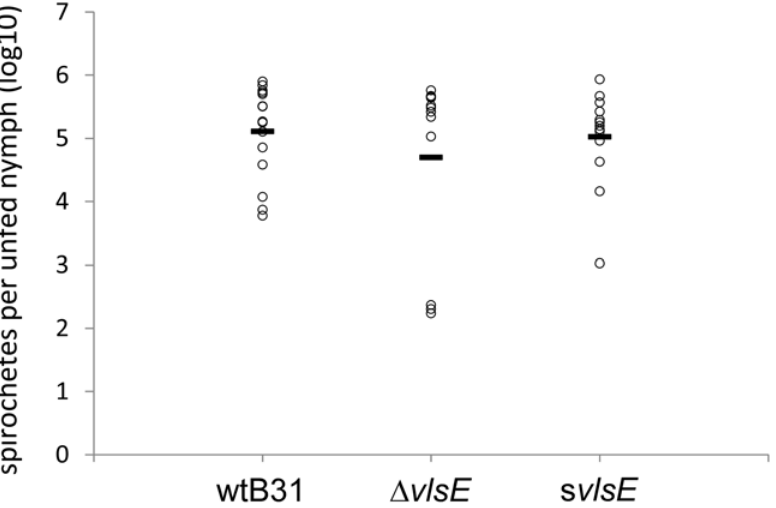
Fig 1. Total spirochete loads of vls mutant B . burgdorferi -infected Ixodes scapularis . Spirochetes in unfed nymphs were quantified by qPCR using a primer and internal probe for flaB . The number of spirochetes (log10) for each individual unfed tick is shown as an open circle. The black horizontal bar given for each B . burgdorferi group represents the overall mean. Only PCR-positive samples are included in this Fig. No statistical difference was observed between wtB31 (n = 15) and Δ vlsE (n = 12) or wtB31 (n = 15) and s vlsE (n = 13) in unfed nymphs, as determined by a two tailed t-test.